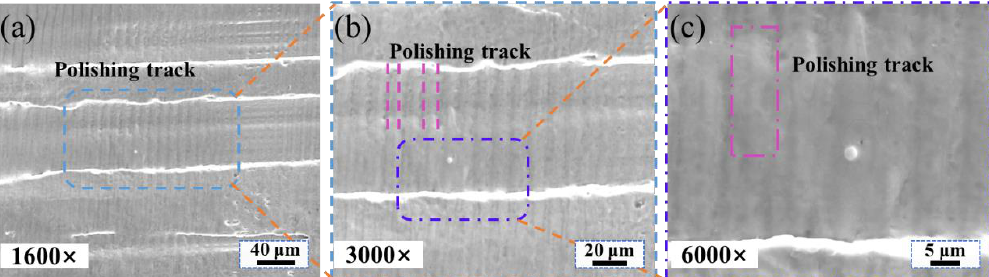
Figure 14. The polished surface with scanning speed of 250 mm/min. ( a ) 1600× magnifications; ( b ) 3000× magnifications; ( c ) 6000× magnifications.